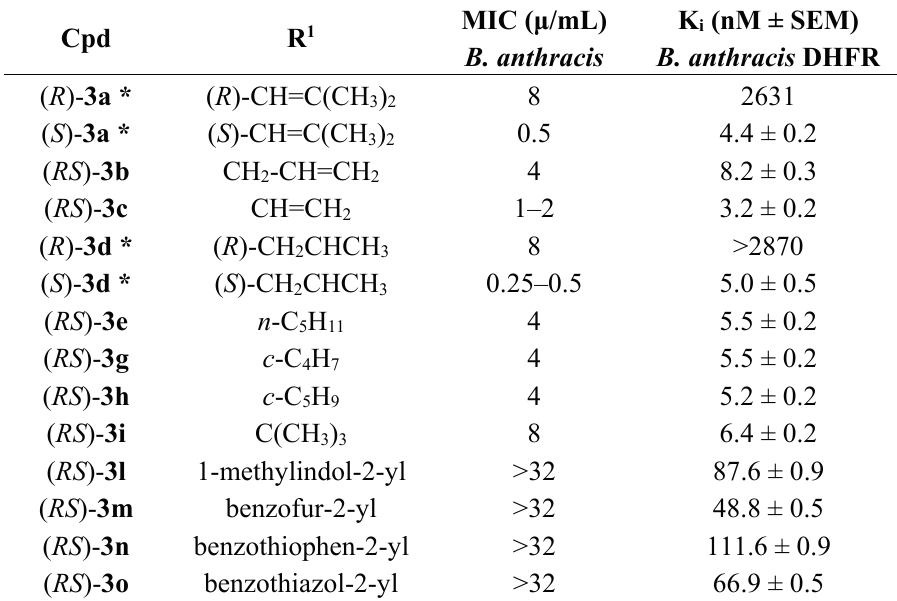
Table 3. MIC values of the inhibitors against B. anthracis and K i values for B. anthracis